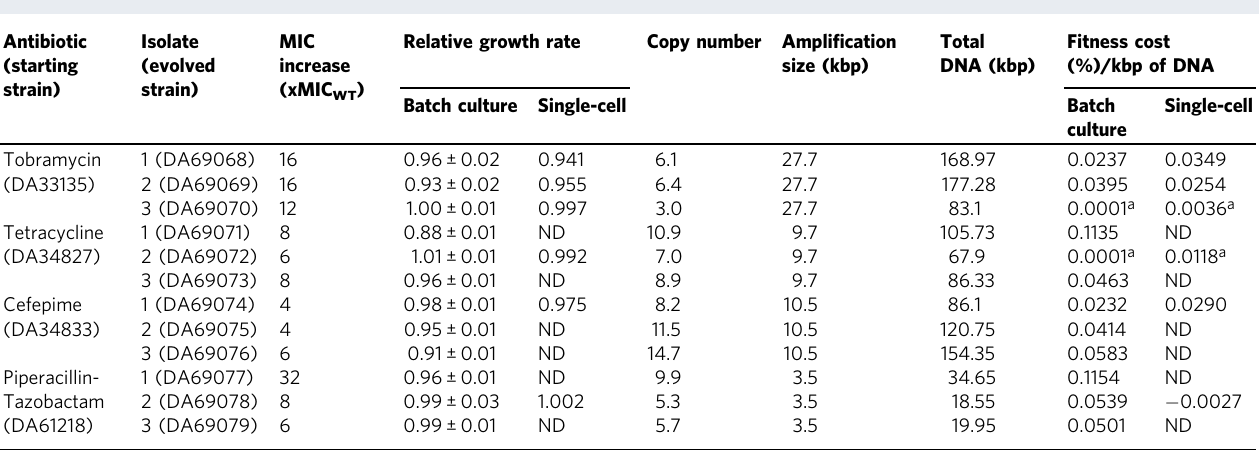
Table 1 Analysis of independent clones evolved for 80 generations at 1x MIC.